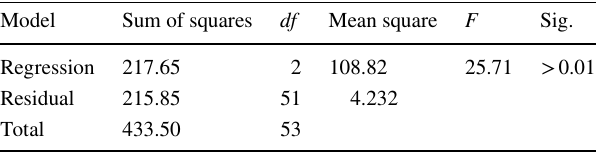
Table 3 The results obtained through the linear model with multivari- ate regression method (alluvial